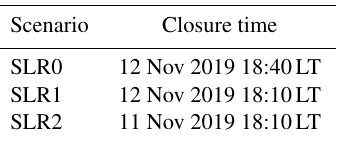
Table 4. Closure times for